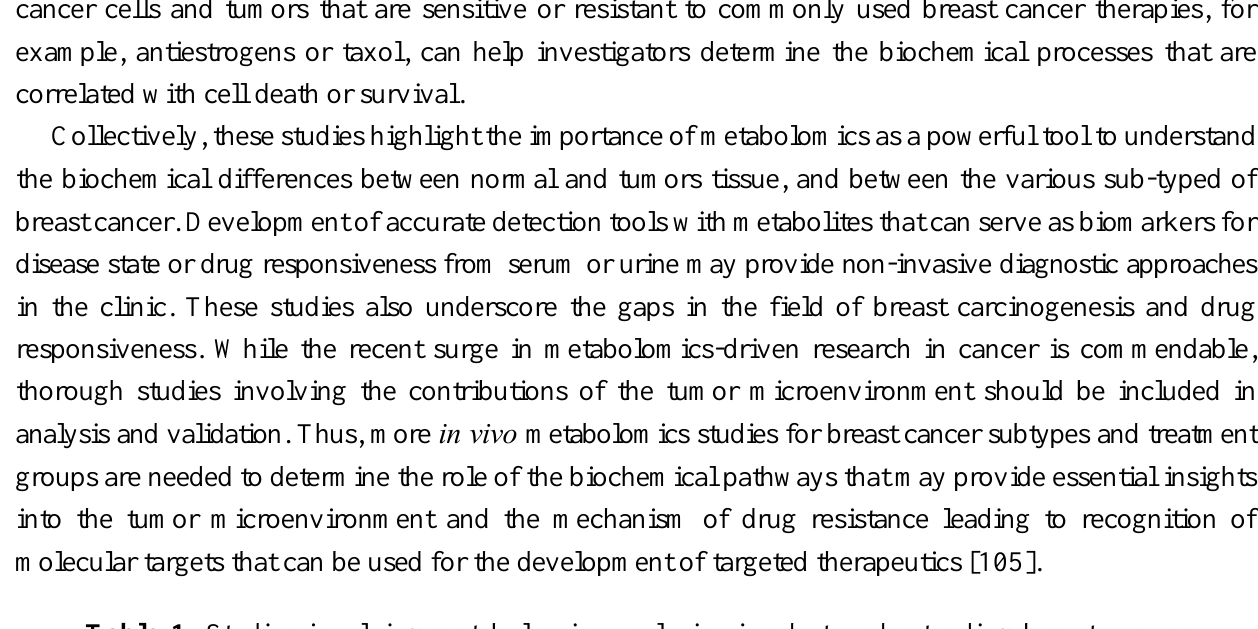
Table 1. Studies involving metabolomics analysis aimed at understanding breast cancer progression and identifying new molecular